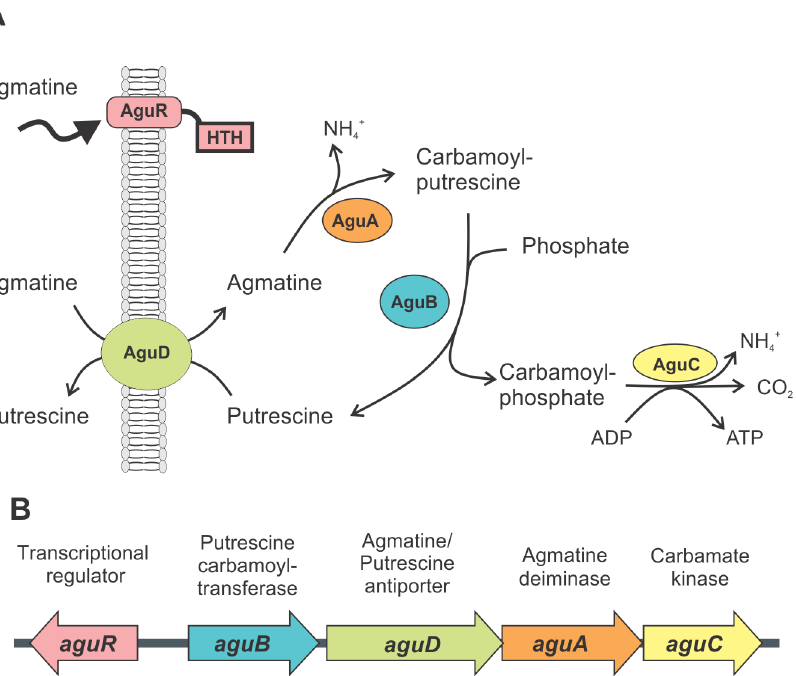
Figure 1. The agmatine catabolic pathway in E.faecalis. A) Schematic representation of agmatine metabolism and B) genetic organization of the agu locus in E. faecalis .